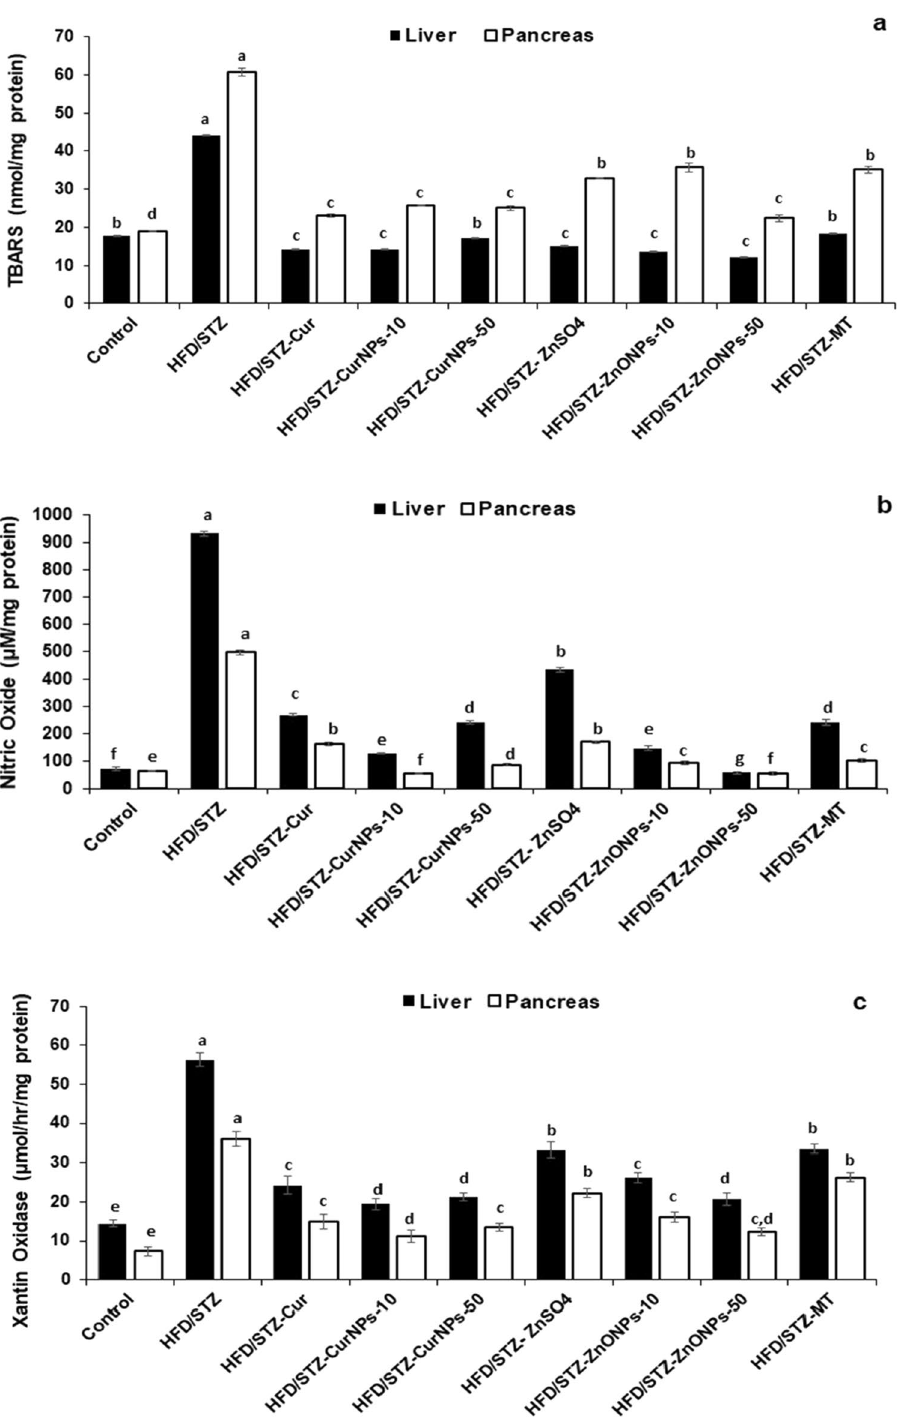
Figure 4. Effect of CurNPs and ZnONPs on change of ( a ) TBARS, ( b ) Nitric oxide and ( c ) Xanthine oxidase levels, ( d ) GPx, ( e ) GST, ( f ) catalase, and ( g ) t-SOD activities, ( h ) GSH and ( i ) TAC levels in liver and pancreas tissues. Values are expressed as mean ± SEM (n = 7), means for the same tissue with different letters in each bar are significantly different (Tukey, p <